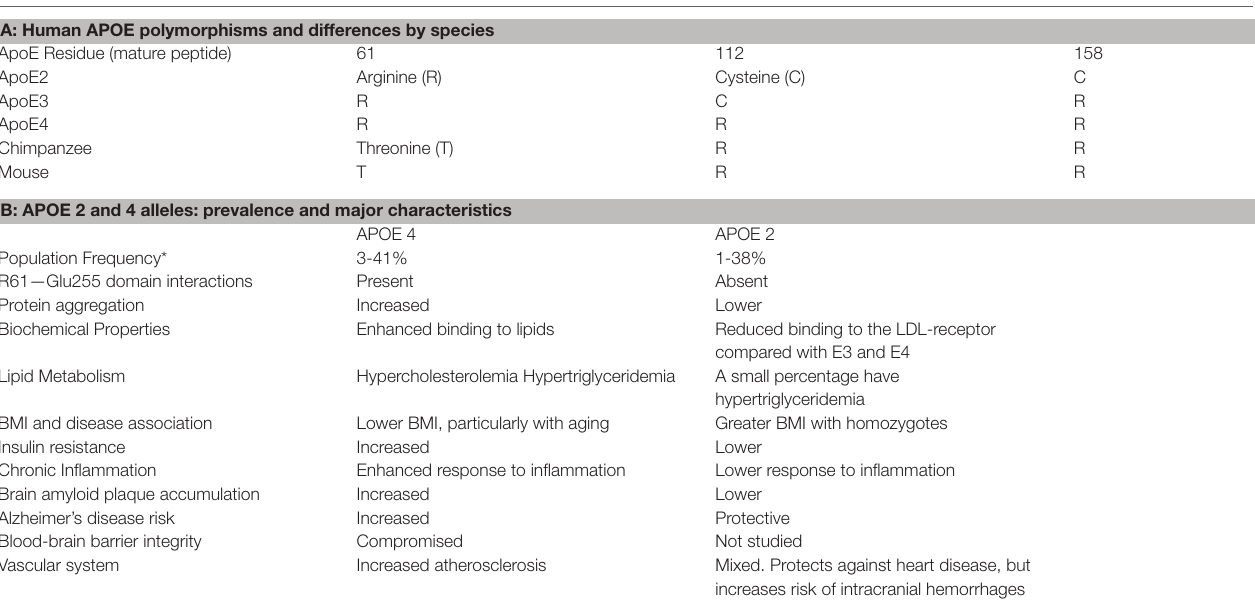
TABLE 1 | Human APOE polymorphisms and differences by